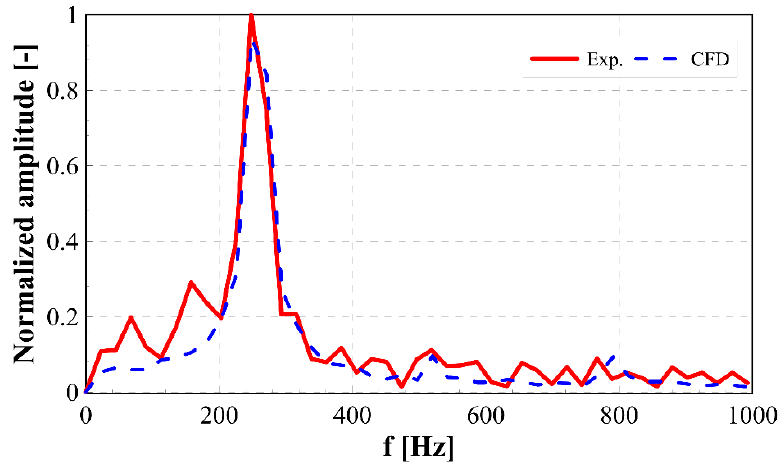
Figure 11. Comparison between the numerical and the experimental flowrates (1500 rpm, 9.5 bar— Configuration 3).